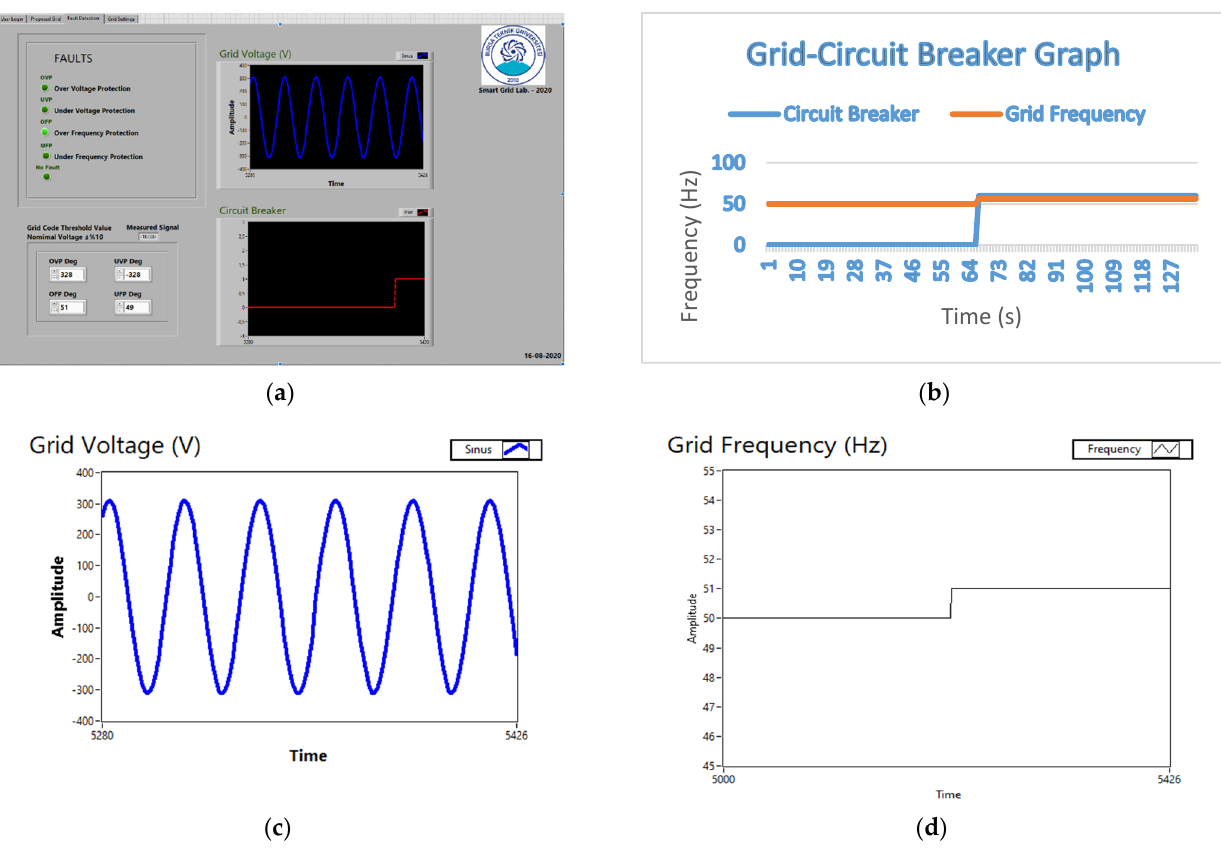
Figure 7. ( a ) OFP condition in DGPS; ( b ) status of CB; ( c ) grid voltage; ( d ) grid frequency.